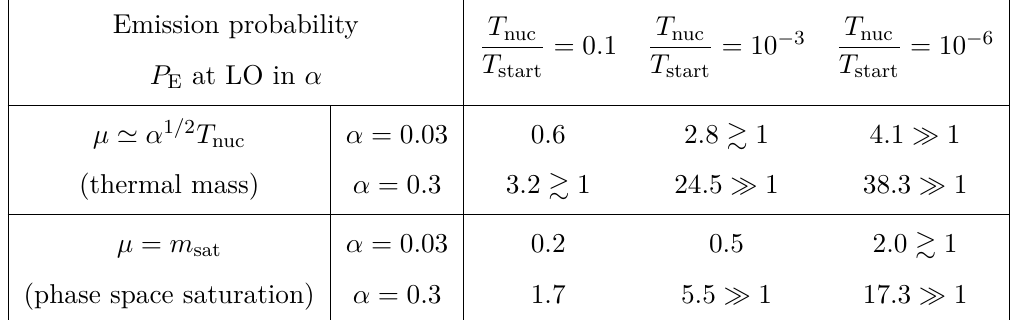
Table 1 . Values of the probability for radiating a single soft vector boson P E in eq. (3.54), for different amount of supercooling, coupling constant α and IR cut-off µ , see section 3.4. We can see that for large supercooling T start /T nuc or large coupling constant α , perturbativity, which we define by P E . 1 , breaks down and the Sudakov logarithms of the fixed-order calculation in eq. (3.54) must be resummed. We have fixed c vac = 0 . 1 and γ equal to the wall Lorentz factor γ coll when bubbles collide, see eq.